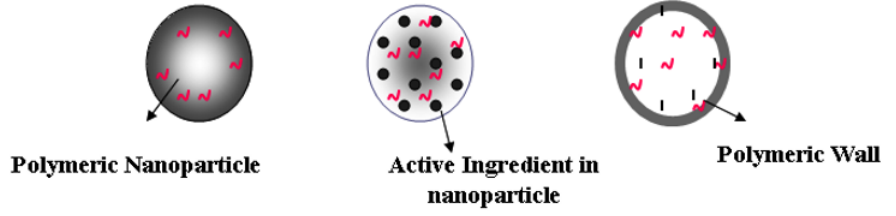
Figure 2. Polymeric nanoparticles for controlled